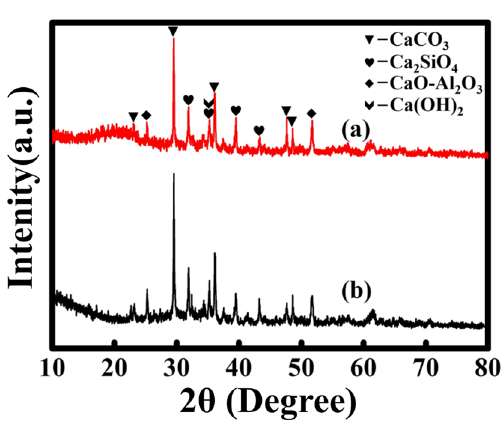
Figure 6. XRD pattern of the expansion material before foaming and after foaming. ( a ) After foaming; ( b ) Before